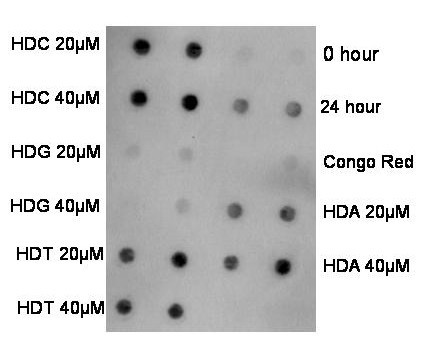
Specificity of monotonic oligonucleotides in the inhibition of mutant Htt fragment aggregation. Various monotonic 20-mers were tested for inhibitory activity in the assay outlined in Figure 1. HDC, 20-mer with all Cs; HDA, 20-mer with all As; HDT, 20-mer with all T's; HDG, 20-mer with all Gs. Four independent experiments were carried out in duplicate and this blot is most representative of all of the results. 0 hour, reaction stopped at zero time point; 24 hour, reaction lacking oligonucleotides, stopped at 24 hours; Congo Red, incubation with 10 μM of Congo Red for 24 hours.